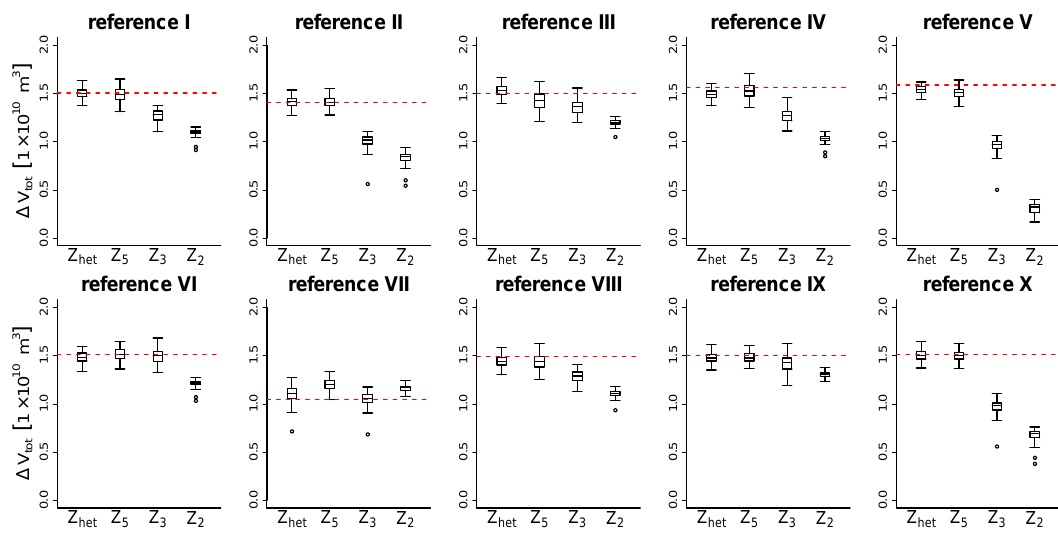
Fig. 13. Total amount of water exchanged between river and aquifer over the whole simulation period (609 days) for conditional simulations with EnKF (scenario C). Red lines mark the water exchange for the different reference runs.